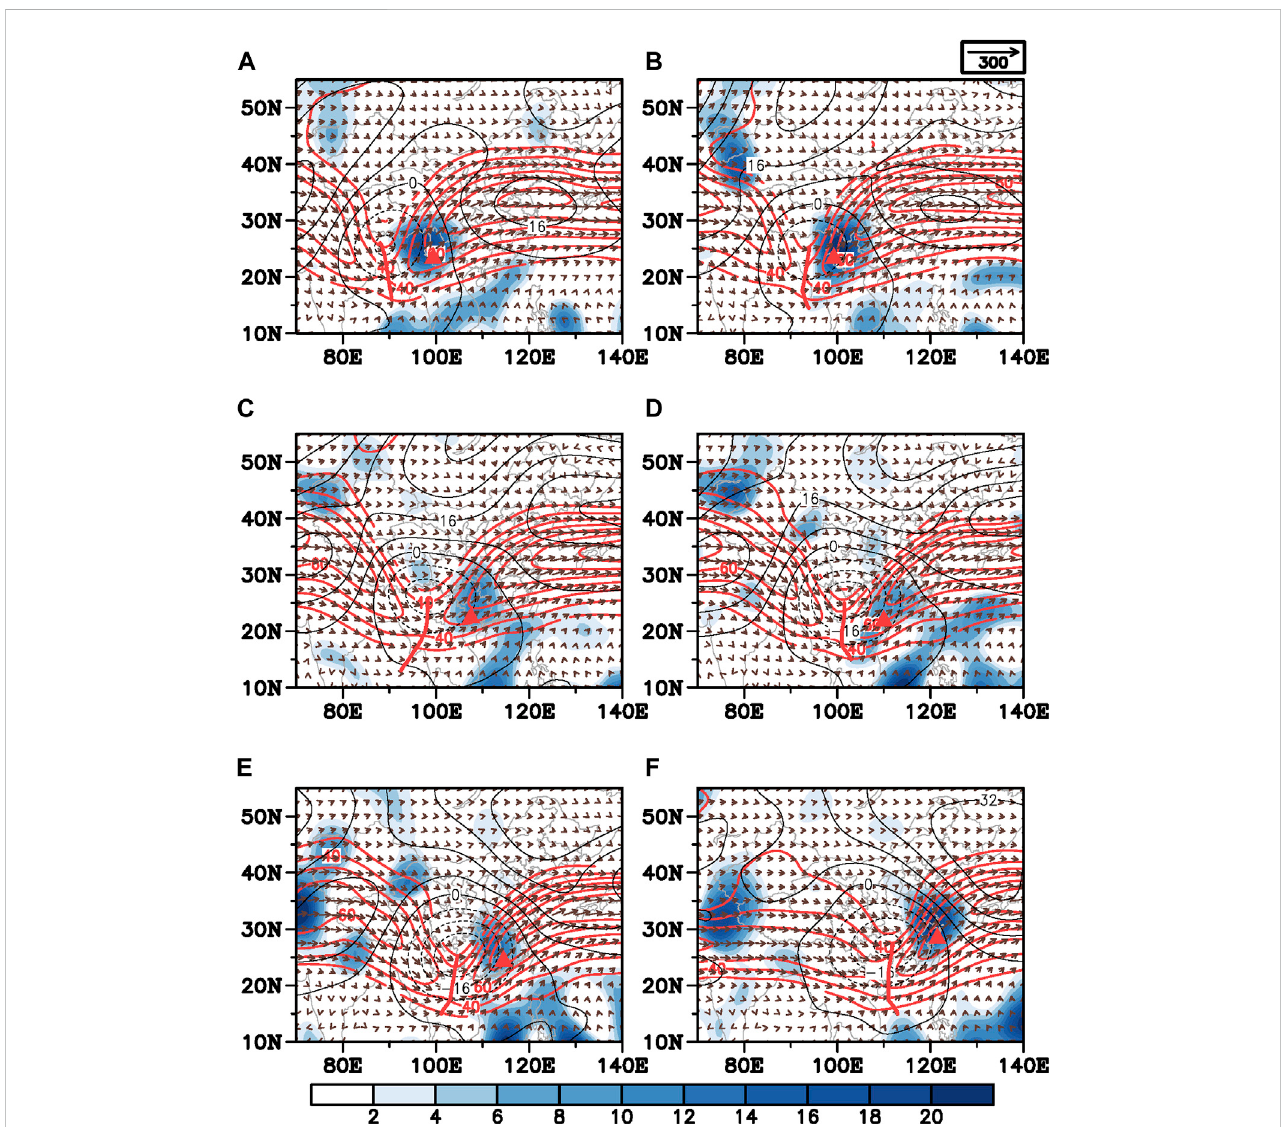
FIGURE 8 Wind fi eld(vectors;units:ms − 1 ),geopotentialheightanomalies fi eld(blackcontours;units:10 gpm)andthedivergenceofthehorizontalwinds(shading; units: 10 – 6 s − 1 ) at 200 hPa on January (A) 8, (B) 9, (C) 10, (D) 11, (E) 12 and (F) 13 in 2015. The red triangle indicates the large-value center of precipitation. Red contours represent zonal wind speeds greater than 30 m · s − 1 and the thick red line shows the trough line of the cyclonic curve appearing in the upper westerly